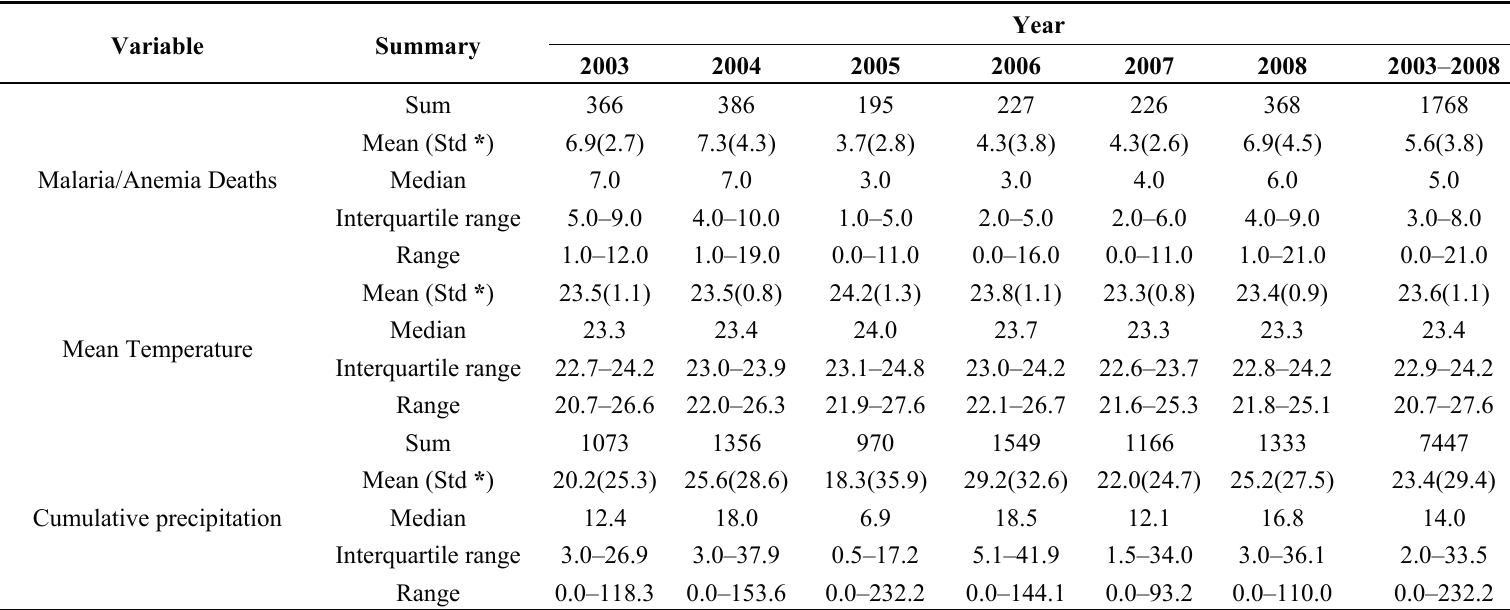
Table 1. Summary statistics (weekly) of malaria/anemia deaths among children under five years, mean temperature (°C) and cumulative precipitation (mm) for the period 2003–2008 in Asembo and Gem. Standard deviation (Std) are provided for mean